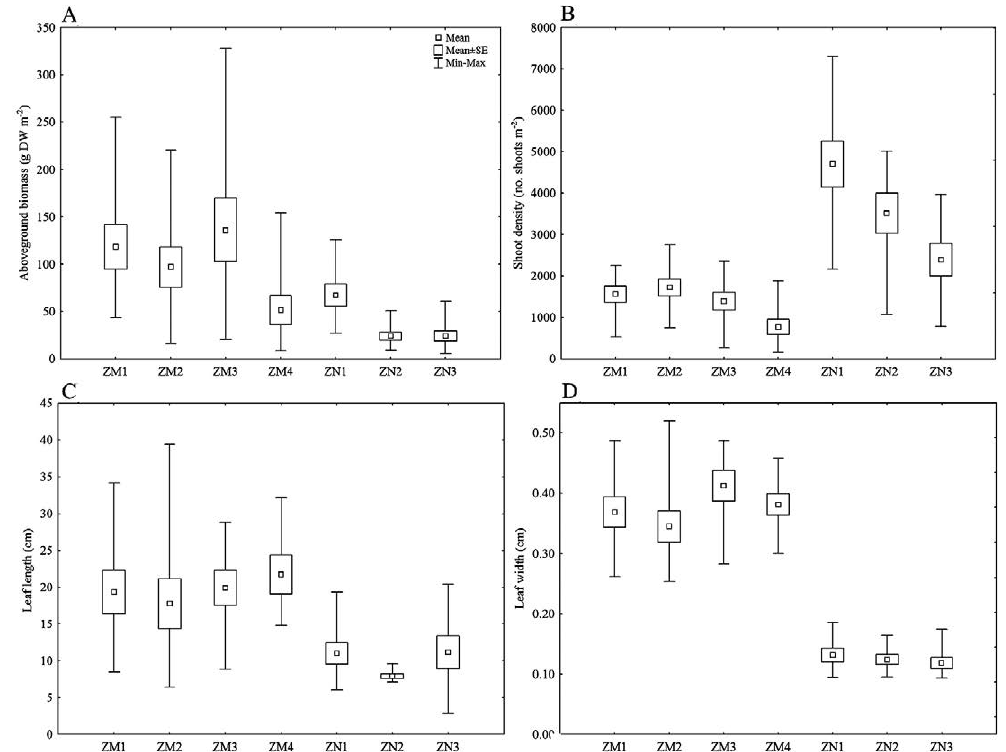
Fig. 3. – Seasonal mean±standard error (2000-2001) for aboveground biomass (g DW m –2 ) (A), shoot density (no. shoots m –2 ) (B), leaf length (cm) (C) and lead width (cm) (D) at the sampling sites of Zostera marina (ZM1-ZM4) and Zostera noltei (ZN1-ZN3) beds.